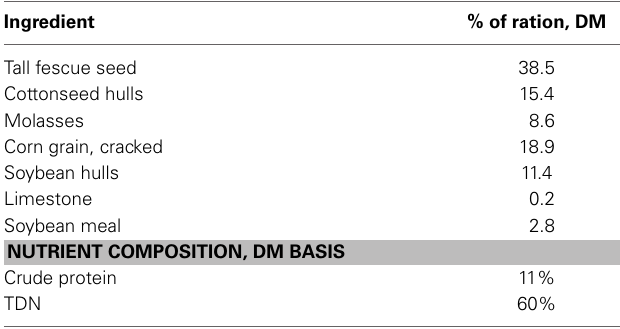
Table 1 | Composition of the total mixed ration